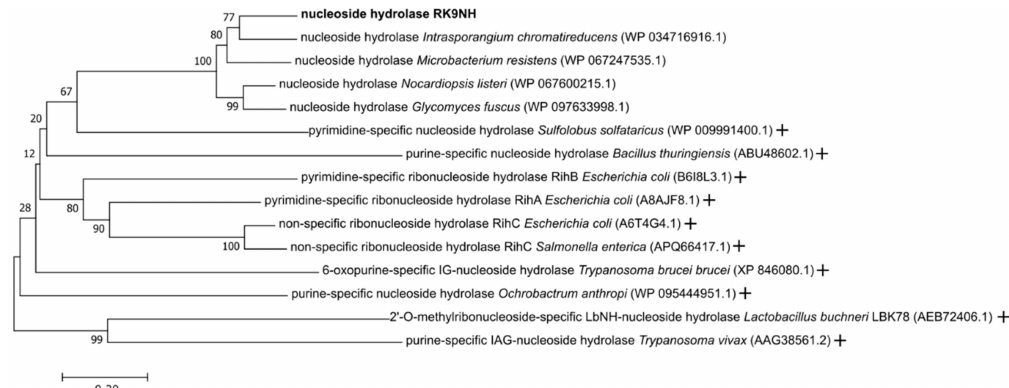
Figure 2. Evolutionary relationships of nucleoside hydrolases. The evolutionary history was inferred using the Neighbor-Joining method [36]. The optimal tree with the sum of branch length = 6.9 is shown. The percentage of replicate trees in which the associated taxa clustered together in the bootstrap test (1000 replicates) are shown next to the branches [37]. The tree is drawn to scale, with branch lengths in the same units as those of the evolutionary distances used to infer the phylogenetic tree. The evolutionary distances were computed using the Poisson correction method [38] and are in the units of the number of amino acid substitutions per site. The analysis involved 15 amino acid sequences. All positions containing gaps and missing data were eliminated. There were a total of 275 positions in the final dataset. Evolutionary analyses were conducted in MEGA7 [34]. RK9NH nucleoside hydrolase is shown in bold. The “+” indicates the enzymes with confirmed functions. The protein accession numbers are in the